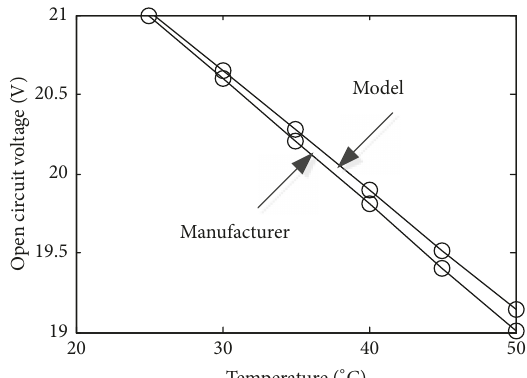
Figure 8: Variation of the open circuit voltage of the TITAN-12-50 panel with